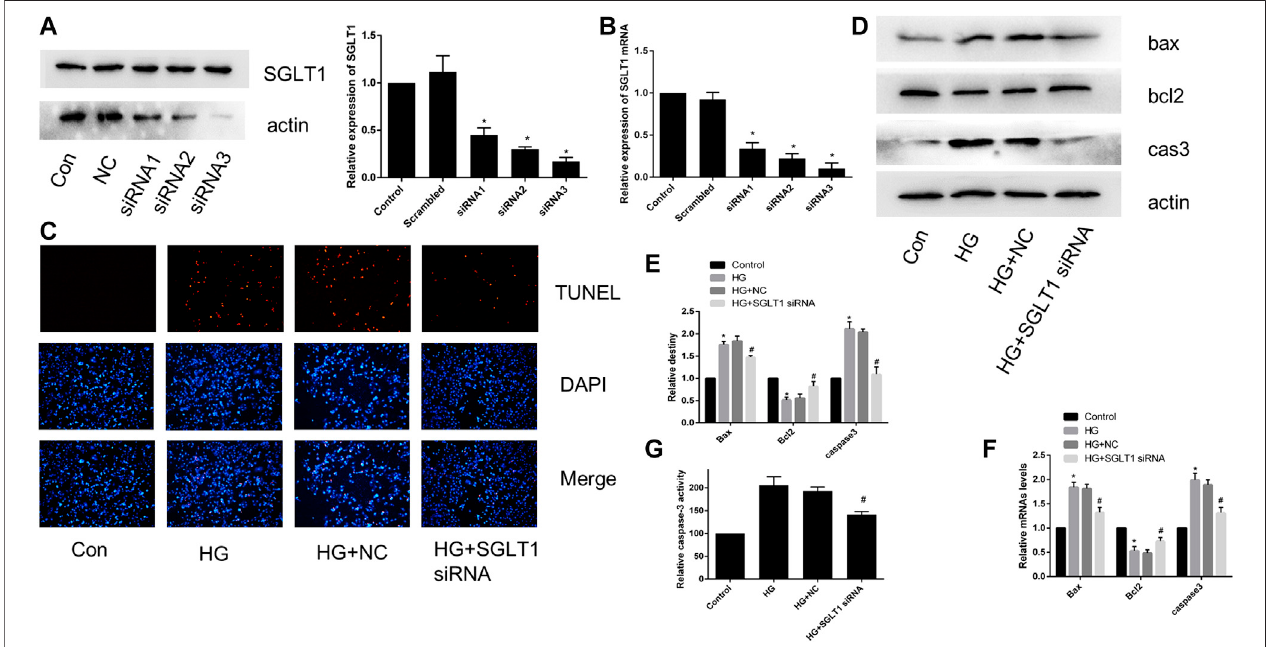
FIGURE 8 | SGLT1 knockdown attenuated apoptosis induced by HG. (A – B) Speci fi c siRNAs targeting SGLT1 were used to knockdown SGLT1, as con fi rmed by westernblottingandRT-qPCR. (C) TheapoptoticratewasdeterminedbyTUNELassay. (D – E) Theexpressionofbax,bcl2,andcaspase-3inH9C2cellsweredetected by RT-PCR and western blot analyses. (F) Caspase-3 activity in H9C2 cells. * p < 0.05 compared with the control group; # p < 0.05 compared with HG group. Experiments were performed in triplicate.